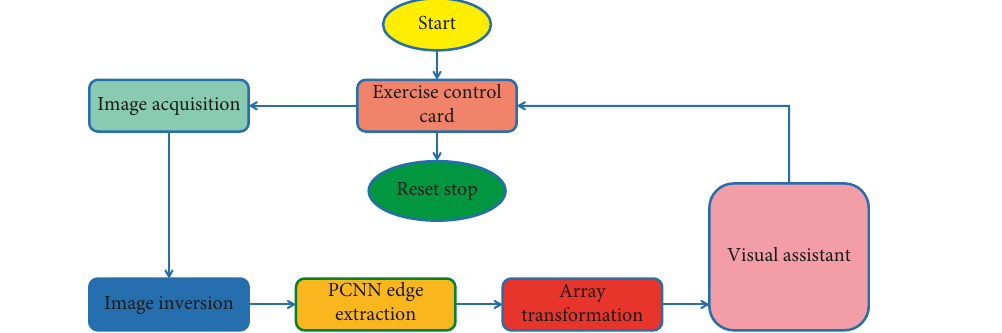
Figure 3: Flow chart of control system.